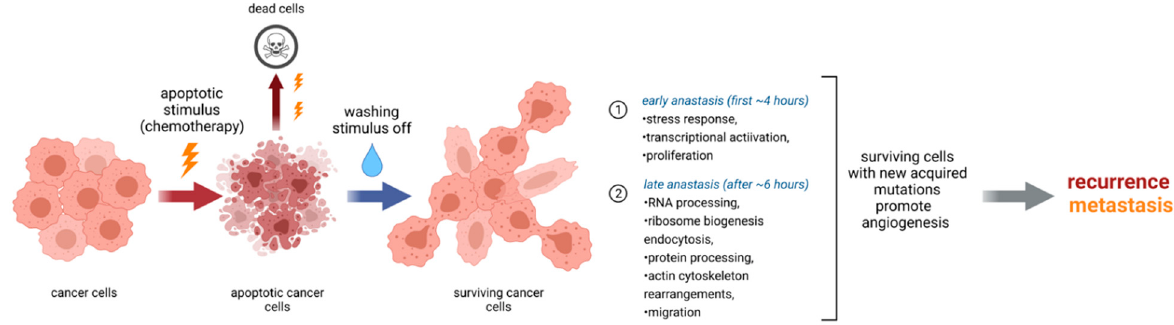
Figure 2. Summary of key events in cells during anastasis. Anastasis can be divided into early and late stages at which different molecular processes dominate. Eventually, cells after anastasis acquire new mutations which make them more prone to recurrence and metastasis after